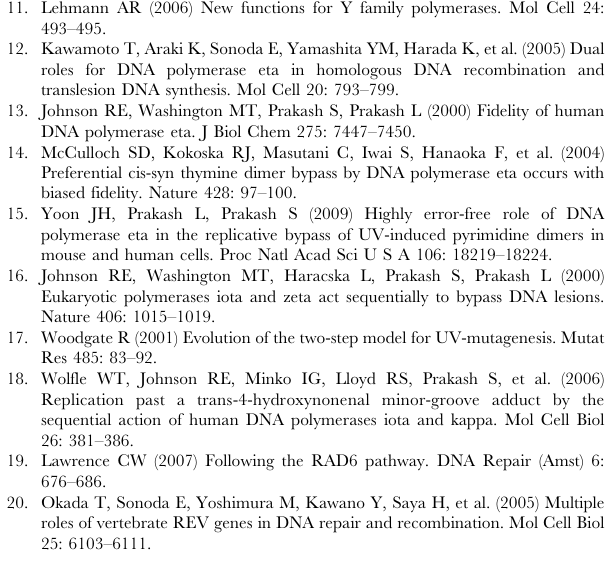
Figure S2 Proliferation of wild-type DT 40 cells carrying human POL g transgene or control expression vector. (A) Expression of the human POL g transgene was examined by Northern blot analysis. The level of endogenously expressed human POL g in 293T cells was below the detection limit, while human POL g expression was detected in DT40 cells carrying the human POL g transgene, indicating that human POL g was overexpressed in DT40 cells. (B) Proliferation of cells was examined for 3 days. Ectopic expression of human POL g in wild-type DT40 cells has no impact on cell